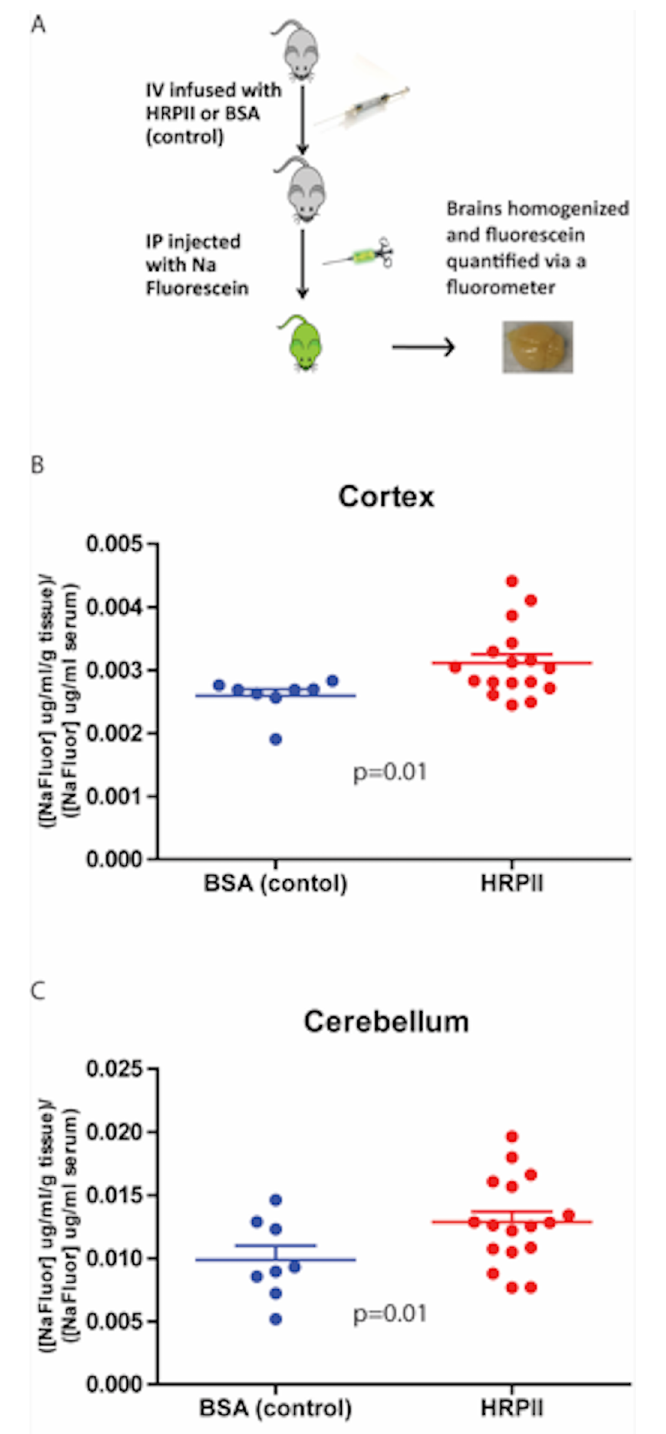
Fig 1. HRPII causes vascularleakage in vivo . (A) Scheme of experimental design. Two doses of HRPII or BSA (200 μ g) were injectedinto 4-week old female C57Bl/6mice at 0 and 24 hours. At 48 hours, fluorescein levels in the cortex ( B ) and cerebellum( C ) of the mice was measured. HRPII treatment was significantly different from control by two-tailed t-test, p = 0.01 (cortex) and p = 0.02 (cerebellum). Data are mean values +/-SEM for 8–16 mice per group accumulatedover 3